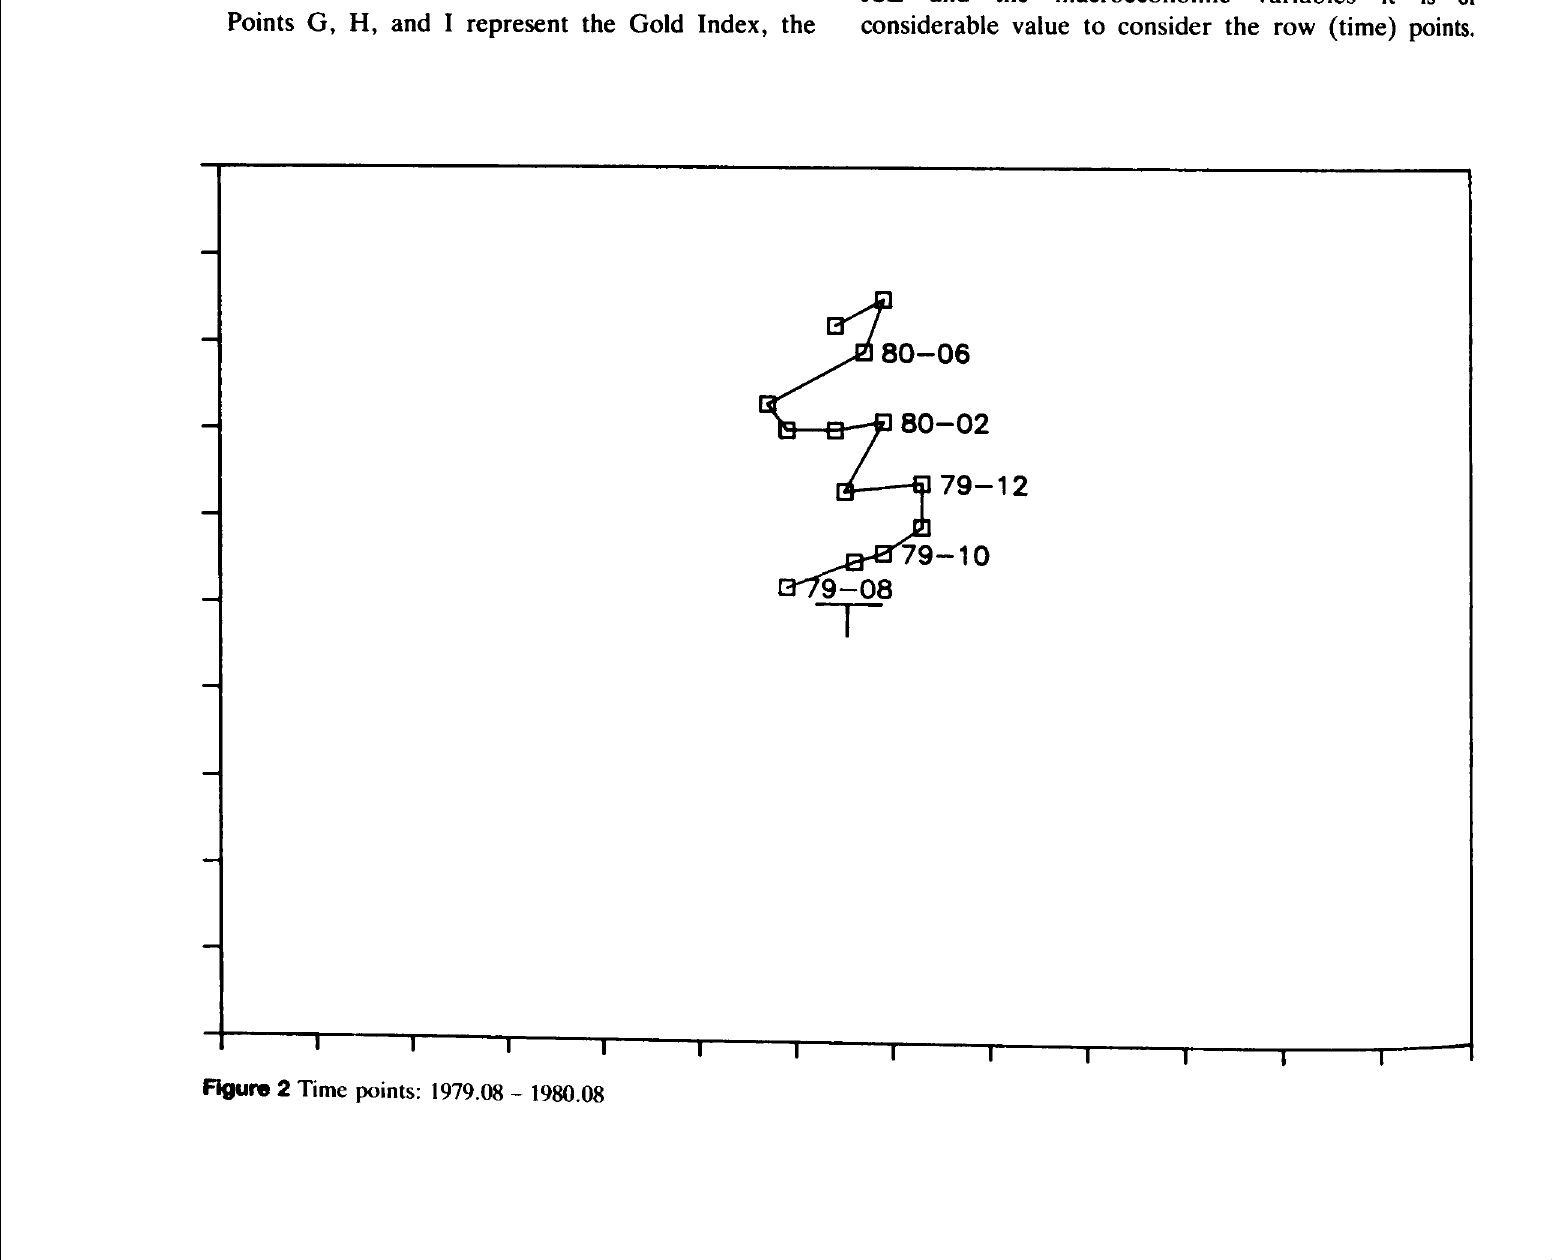
Figure 2 Time points: 1979.08 -